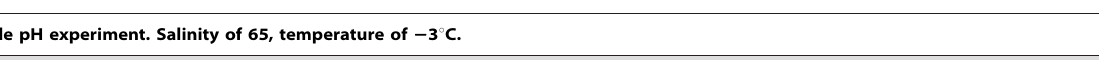
Table 1. Carbonate chemistry of CO 2 manipulation experiments on sea ice brine algae from McMurdo Sound, 2012.